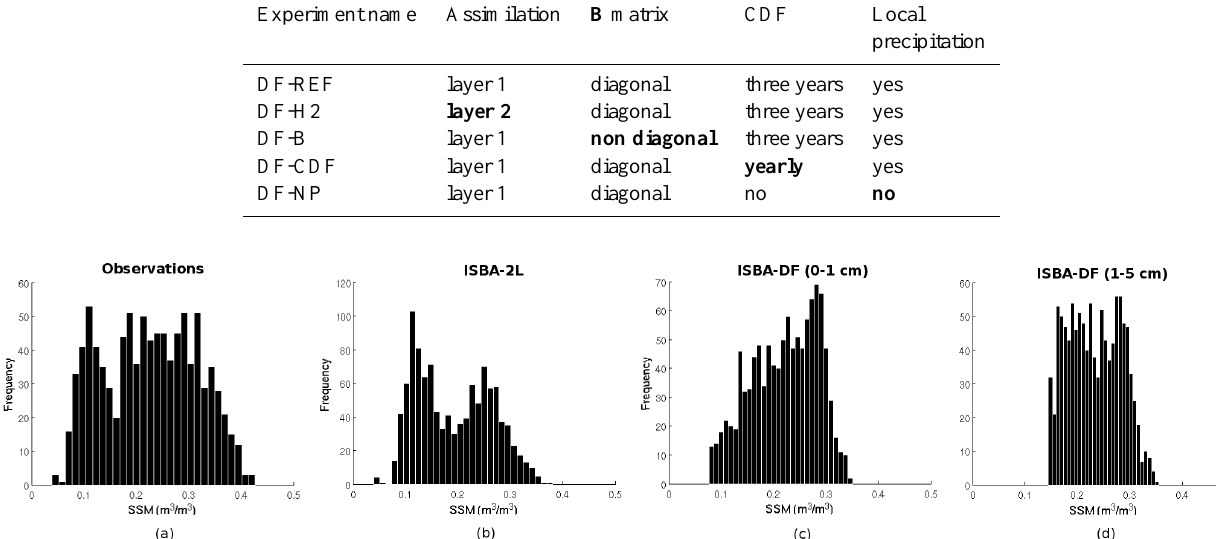
Table 1. Description of the ISBA-DF experiments. Bold face indicates changes in the assimilation experiments with respect to ISBA-DF reference experiment (DF-REF). Experiment name Assimilation B matrix